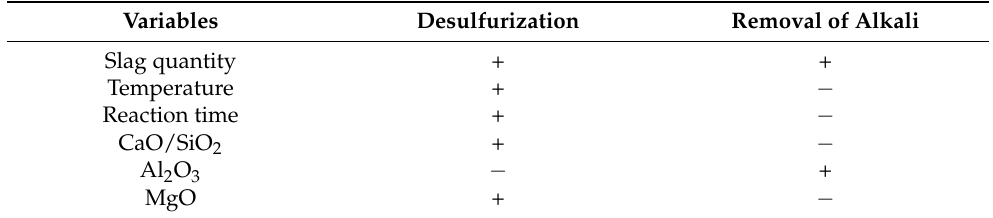
Table 4. Summary of the desulfurization and the removal of alkali by different parameters, + indicates positive effect, − indicates negative effect. Variables Desulfurization Removal of Alkali Slag quantity + + Temperature + − Reaction time + − CaO/SiO 2 + − Al 2 O 3 − + MgO +